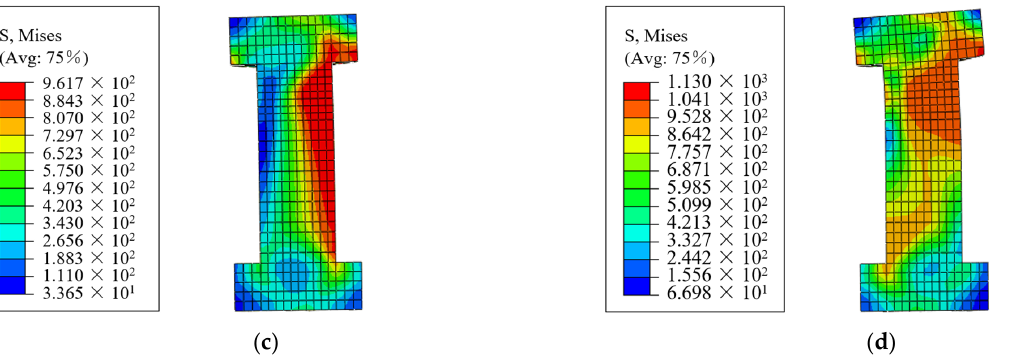
Figure 13. T-stub connection stress cloud diagram during loading: ( a ) stress cloud diagram at point A; ( b ) stress cloud diagram at point B; ( c ) stress cloud diagram at point C; ( d ) stress cloud diagram at point D.